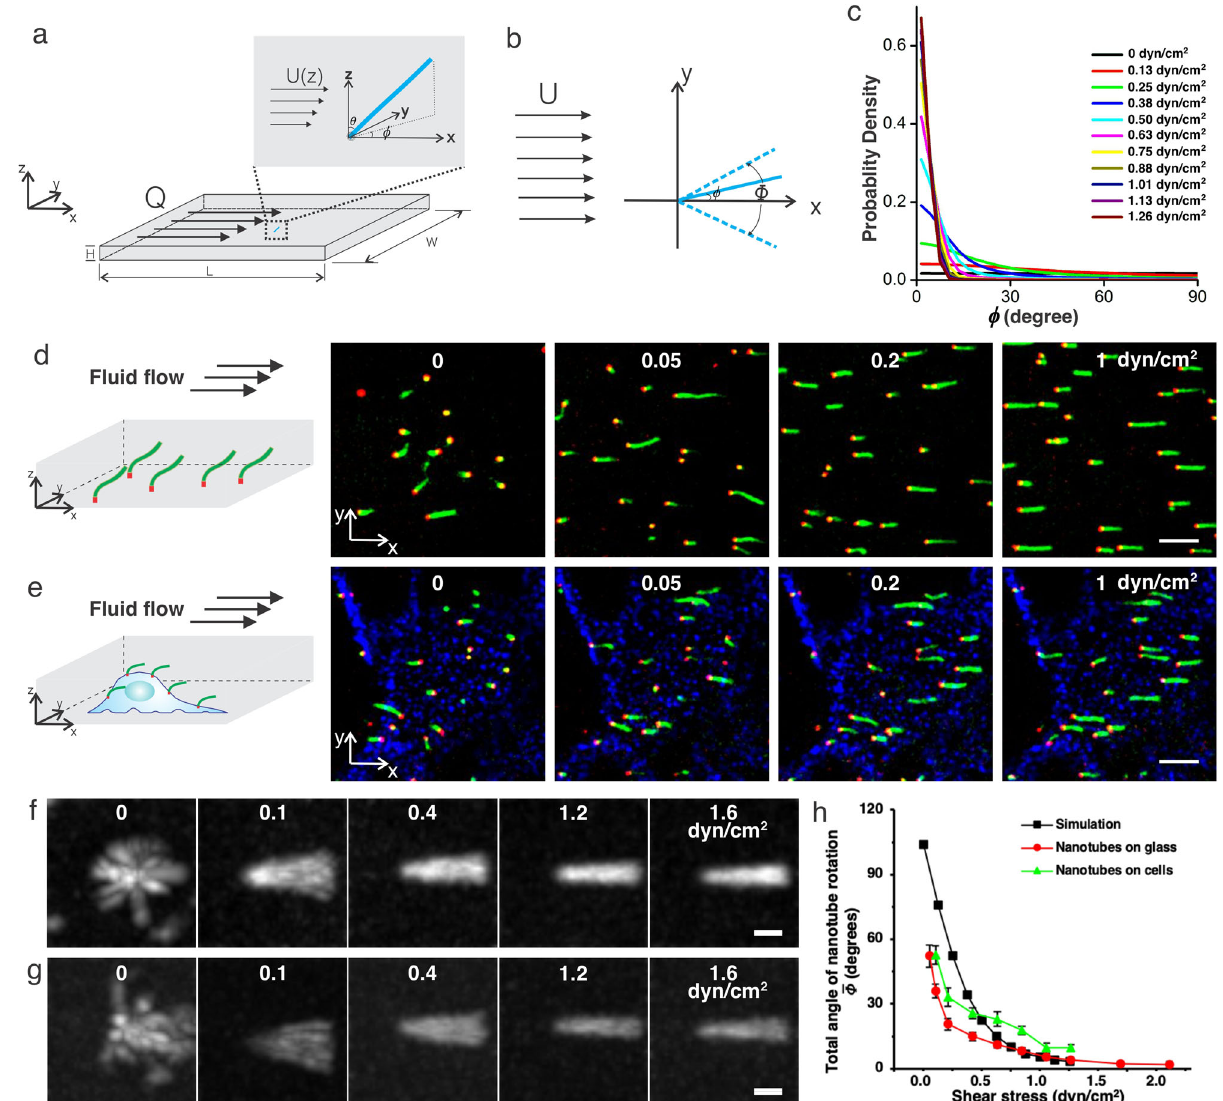
Fig. 4 Anchored nanotubes indicate the magnitude of shear stress at the cell surface. a , b Side ( a ) and top ( b ) views of nanotube de fl ection in a fl ow Q in a rectangular channel. ϕ is the azimuthal angle between the plane of the nanotube and the x -axis. Φ is the total angle of nanotube rotation over a given time duration. c Predicted distribution of ϕ by a simple model of de fl ection (Supplementary Note S44.3). d , e Confocal micrographs of seeded nanotubes anchored on the glass surface of a rectangular fl ow chamber (see the “ Methods ” section) ( d ) and the top of HeLa cell membranes ( e ) in response to fl uid shear stresses of 0, 0.05, 0.2, and 1 dyn/cm 2 . Nanotubes were labeled with Cy3 (green), nanotube seeds with atto647 (red), and the cell membrane visualized with streptavidin-Alex488-conjugated EGFR antibodies (blue). Scale bars: 10 μ m. More than three times of this experiment were repeated independently with similar results. f , g Maximum projection images of seeded nanotubes anchored on glass ( f ) and on HeLa cells ( g ) in response to fl uid shear stresses 0, 0.1, 0.4, 1.2, and 1.6 dyn/cm 2 . Scale bars: 2 μ m. More than three times of this experiment were repeated independently with similar results. h Mean total angles of nanotubes as a function of fl uid shear stress. N = 15 nanotubes for each shear stress on both glass and cells. Error bars here are 95% con fi dence